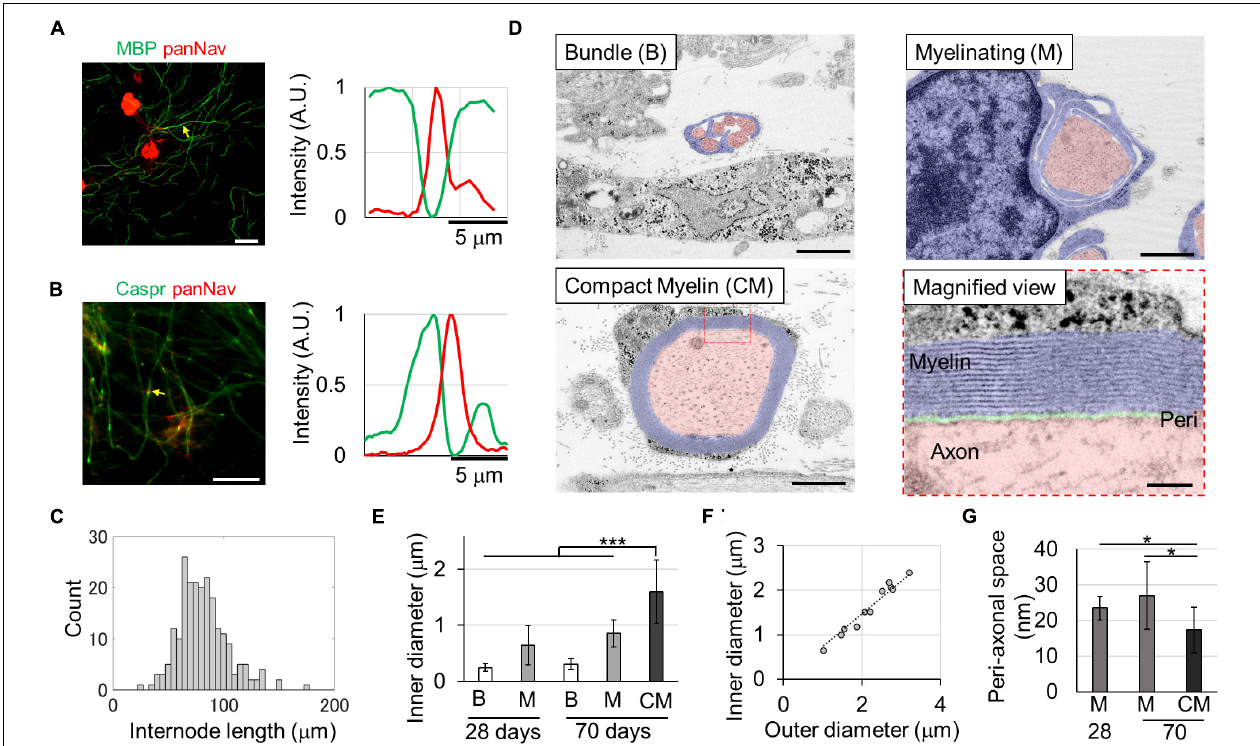
FIGURE 1 | In vitro myelin sheath formation. Myelin sheath (A) and paranode formation (B) at 29 days in vitro (DIVs). Relative fluorescence intensities around the yellow arrows are shown in right panels. The myelin basic protein (MBP) or Caspr and panNav protein were alternatively expressed along axons. Heminodes with a single Caspr spot and one panNav spot were also observed. Histogram of the internode length (C) . Ultra-structures of the myelin sheath (D) . Fully myelinated axons with compact myelin (CM) were observed at the 70th DIV. The diameter of myelinated axons was significantly larger than that of other axons (E) . The g-ratio, which is the ratio between inner and outer diameters, was 0.74 (F) (R 2 = 0.896, p = 3.1 × 10 - 13 ). The peri-axonal space indicated in green in the magnified image was smaller in myelinated axons than in wrapped axons (G) . * p < 0.05, *** p < 0.001; Student’s t test. Error bars indicate standard deviation. Scale bars, 50 µ m in panels (A,B) ; 1 µ m in panel (D) ; 100 nm in panel (D) magnified